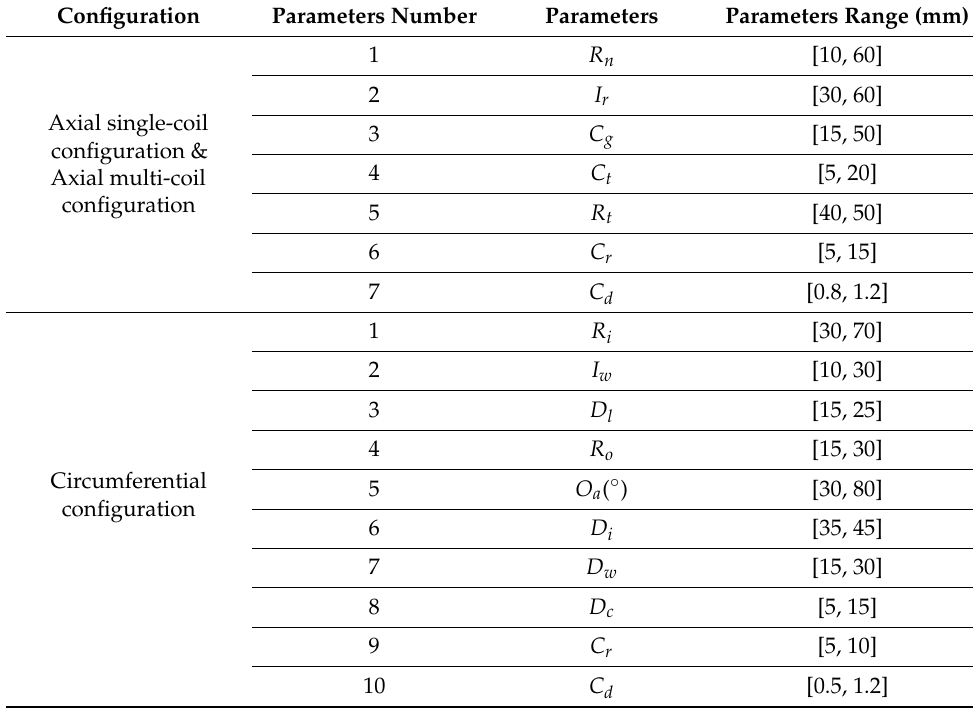
Table 7. Allowable values of the design variables for MR-TVA.